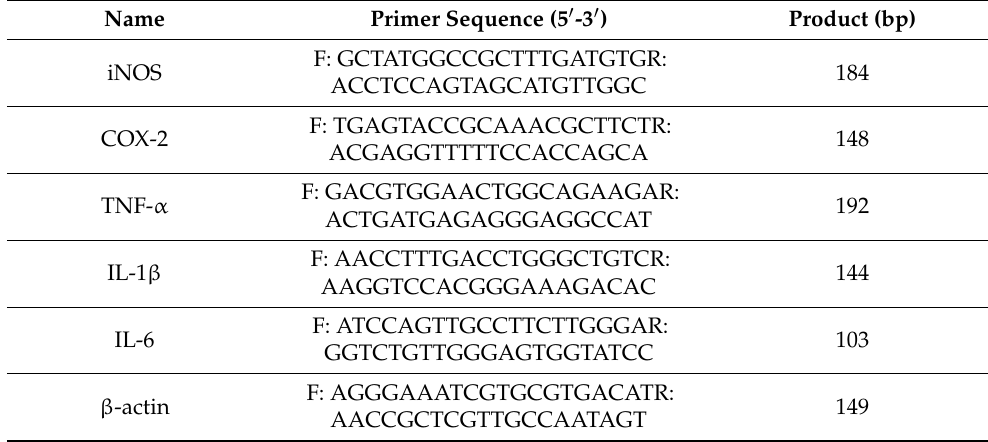
Table 1. Reverse transcription polymerase chain reaction primers were